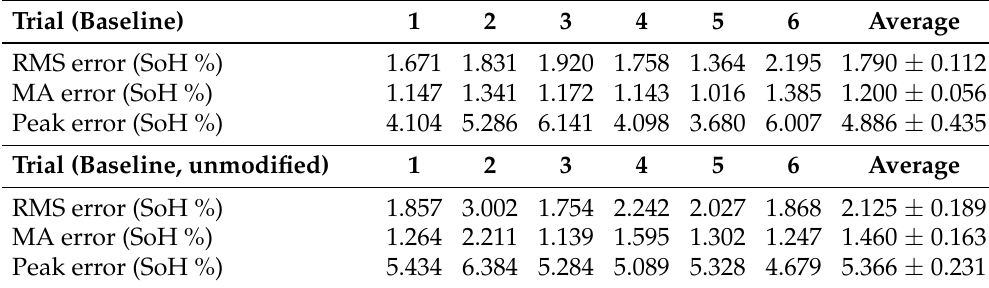
Table 3. Six-fold cross-validated RMS, mean absolute (MA), and peak prediction errors of state of health estimation for the baseline neural network model based on modified and unmodified Randles equivalent circuit model parameter